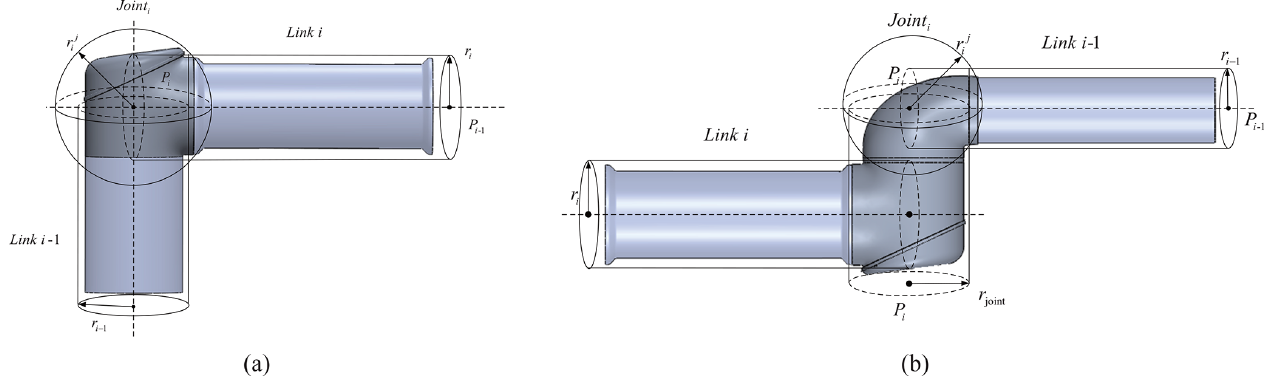
Figure 2. Links of the manipulator use cylindrical envelope and sphere envelope. (a) Case I. (b) Case II.